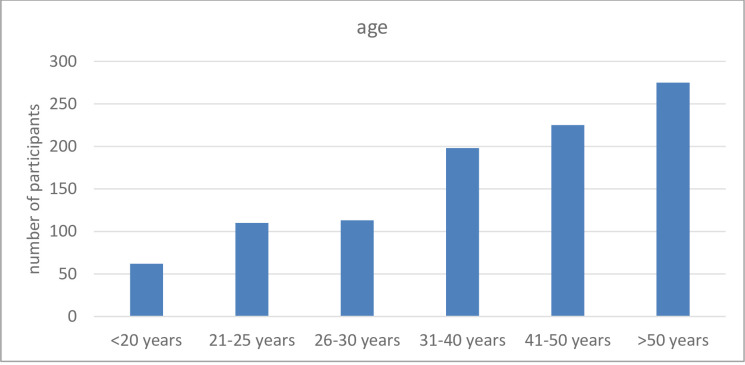
Overview of the age distribution among the questioned people.